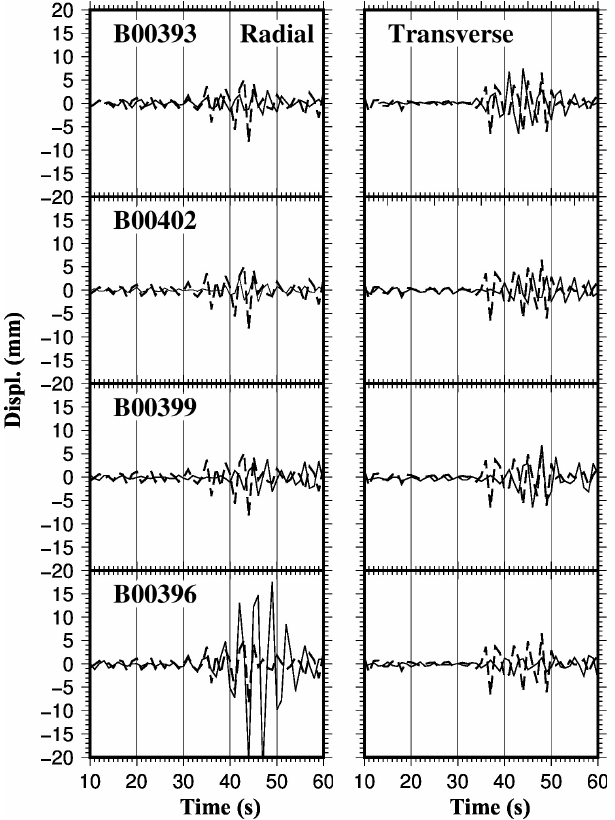
Figure 9. MEMS and HRGPS (thick dashed line) displacements in the Radial-Transverse coordinate system. Thick dashed lines and thin solid lines represent respectively the HRGPS and MEMS dis- placements. The MEMS signals of the four stations are arranged in decreasing order from top to bottom according to epicentral dis- tances, and the code of each instrument is reported on the fig- ures. The horizontal axis denotes seconds from the origin time of the main shock: 01:36:32UTC of 24 August 2016. (Built with the Generic Mapping Tool software GMT – Creative Commons Attri- bution 4.0